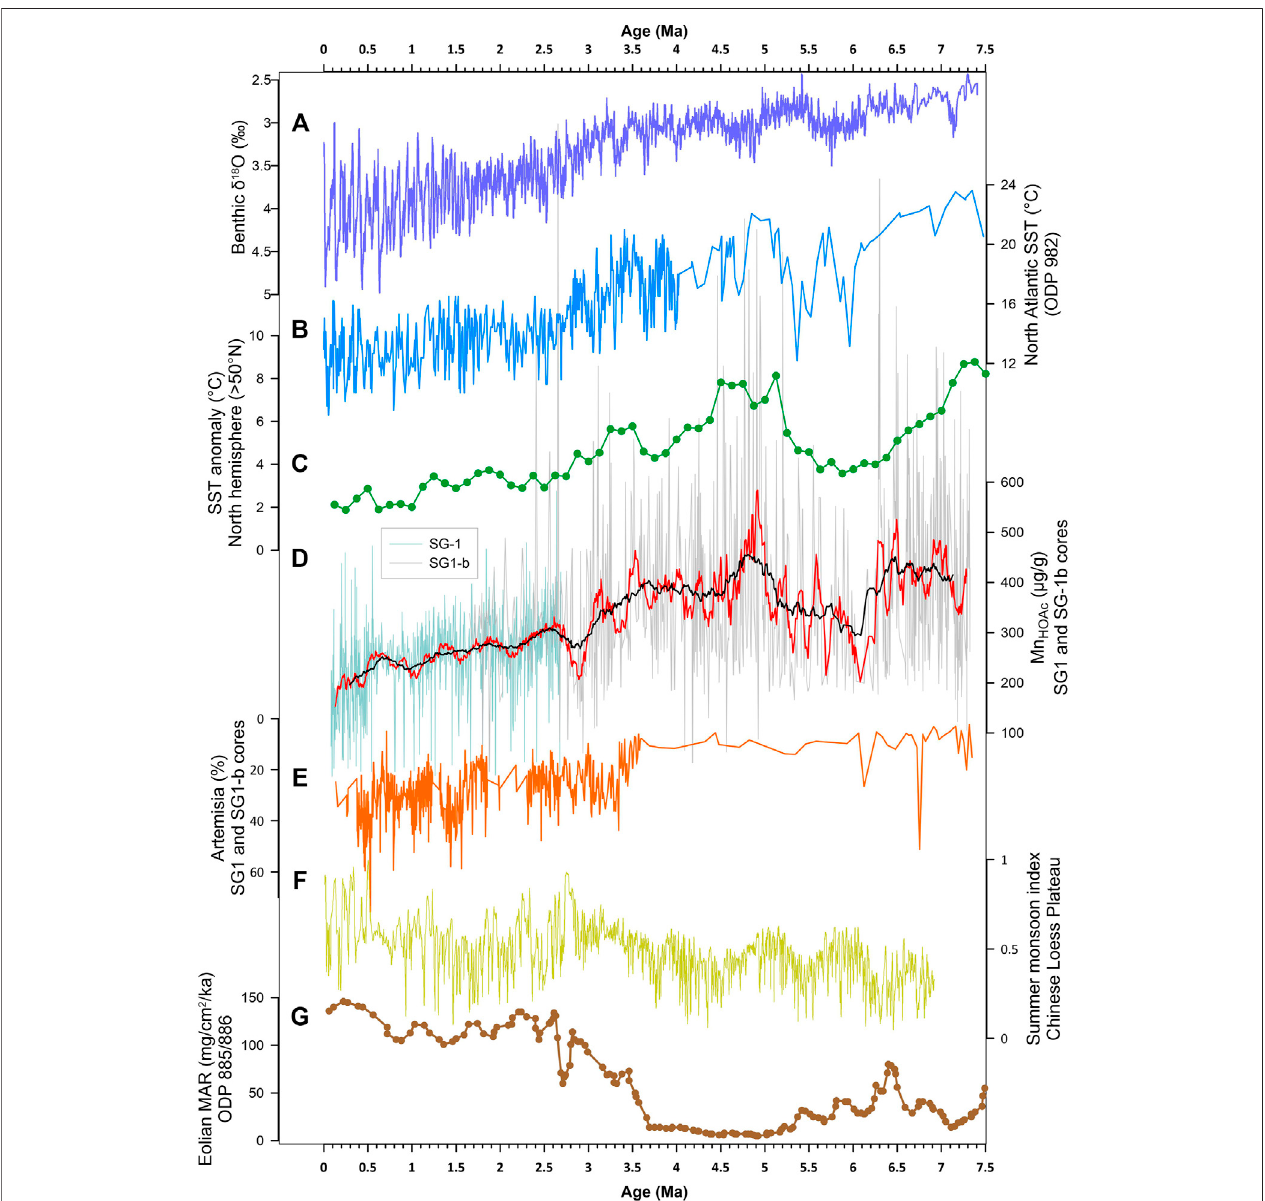
FIGURE5| IntegratedMn HOAc recordoftheSG-1bandSG-1drill-coressince7.3 MaintheQaidamBasincomparedwithotherrecords. (A) Globalmarinebenthic foraminiferal δ 18 O record ( ‰ ) (Zachos et al., 2001). (B) Alkenone-derived sea surface temperature (SST) record from the North Atlantic Ocean at ODP Site 982 (Herbert et al., 2016). (C) Stacked high latitude SST anomalies in North Hemisphere (Herbert et al., 2016). (D) Mn HOAc record over the past 7.3 Myr (raw data, grey lines for the SG-1bcoreand lightblue-green linesfortheSG-1core;redandblack linesare100-and 400-kyrsmoothingoftherawdata,respectively). (E) Artemisiacontentof theSG-1bandSG-1cores(Koutsodendrisetal.,2019). (F) SummermonsoonindexintheChineseLoessPlateau(Sunetal.,2010b). (G) Massaccumulationrate(MAR) of eolian dust at Site 885/886 in the northern Paci fi c Ocean (Rea et al., 1998).